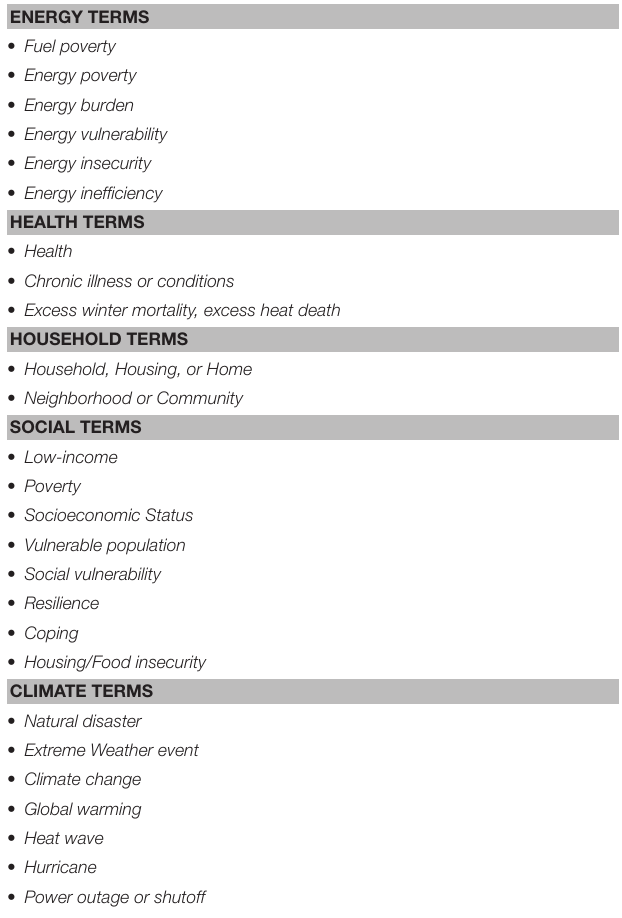
TABLE 1 | Search terms used in the literature